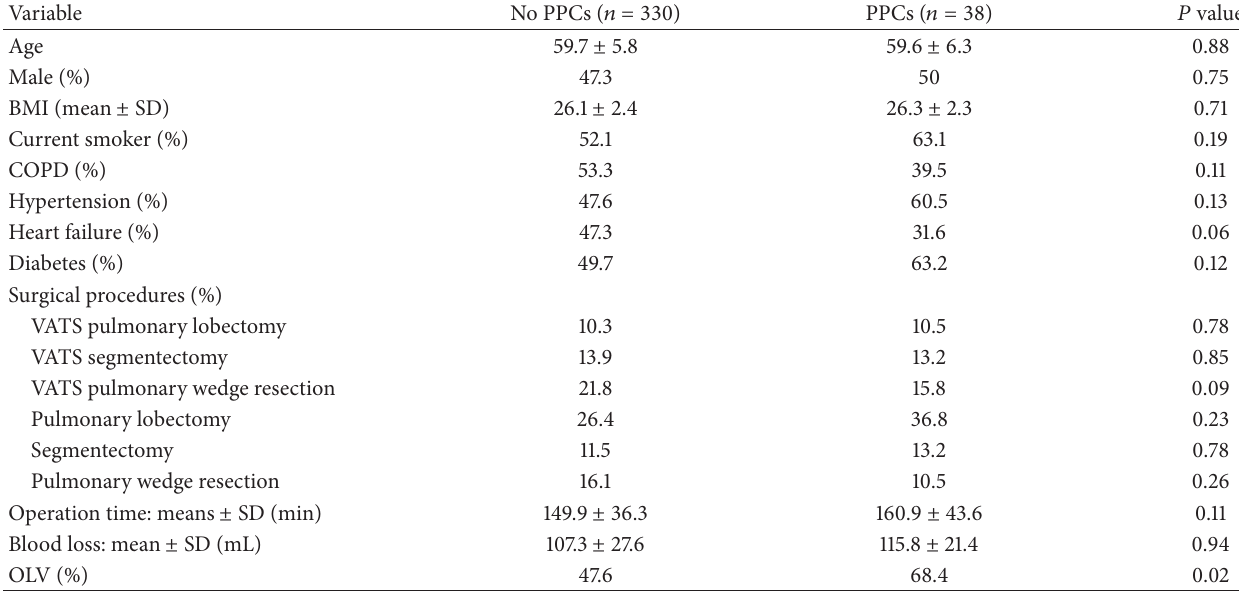
Table 3: Clinical characteristics in patients with and without PPCs.